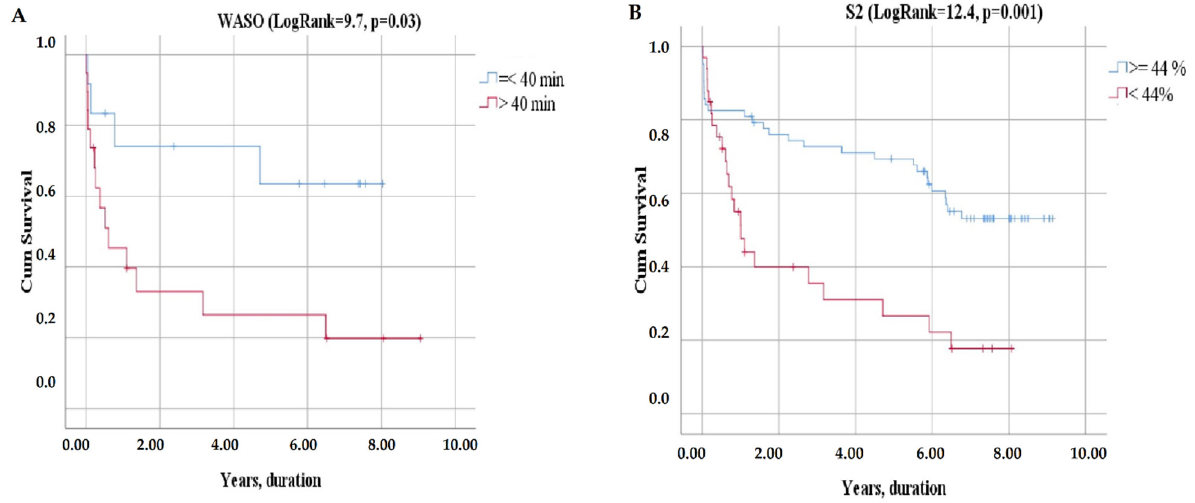
Figure 6. Kaplan–Meier curves of event-free survival according to PSG parameters: WASO ( A ), S 2 ( B ).